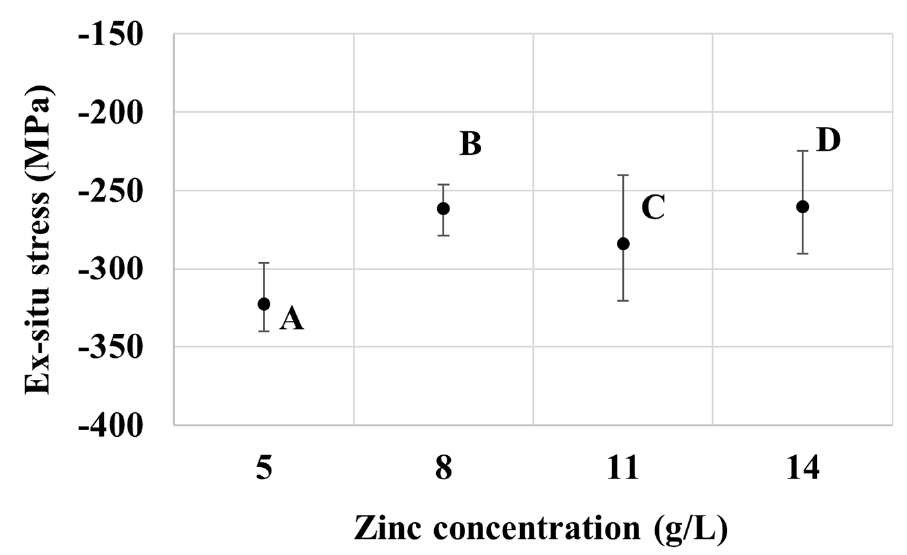
Figure 6. E ff ect of zinc concentration on the ex-situ stress of samples from baths A, B, C, and D.